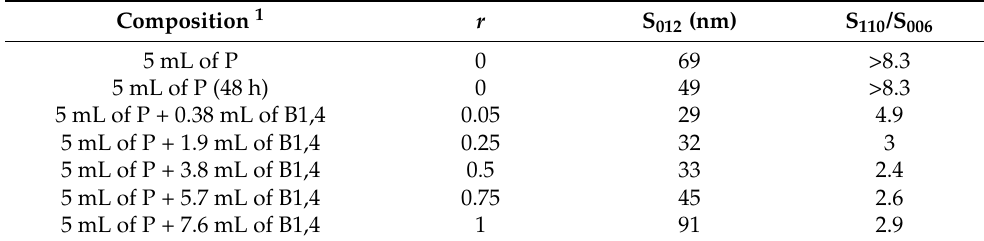
Table 2. Evolution of the mean nanocrystal size S 012 (in nm) and anisotropic ratio for a fixed volume of precursor at 5 mL and increasing values of r upon addition of 1,4-butanediol. The number of moles of ethanol was 8.57 × 10 − 2 , whereas for 1,4-butanediol it was increased from 4.30 × 10 − 3 ( r = 0.05) to 8.57 × 10 − 2 ( r = 1.0). The number of moles of ethoxy groups coming from the alkoxide precursor